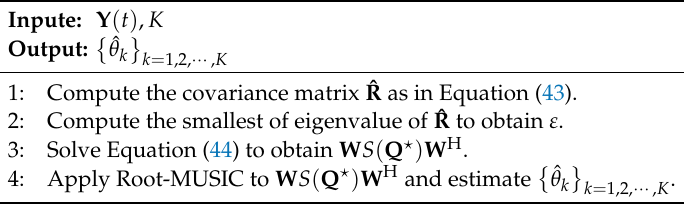
Table 2. DOA estimation algorithm via BS-ANM.